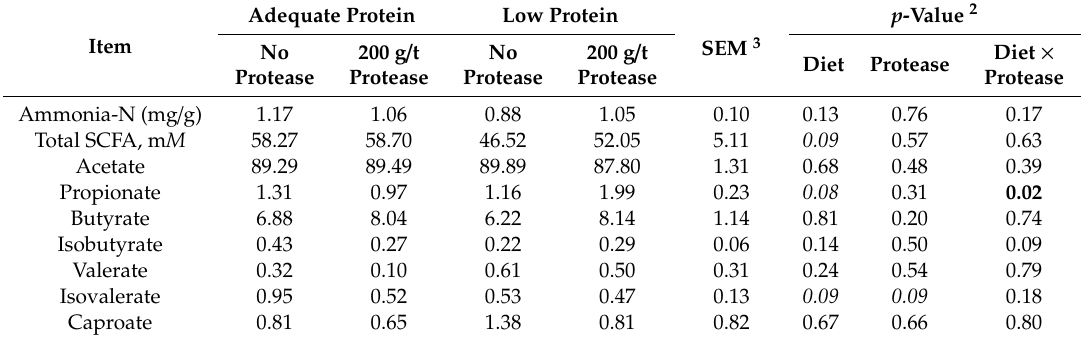
1 Adequate protein: diet with adequate levels of essential amino acids; low protein: diet with marginally deficient levels of essential amino acids. 2 p ≤ 0.05 are emboldened to highlight significant di ff erences. Trends, italicized, are defined as 0.10 ≥ p > 0.05. 3 SEM = standard error of the